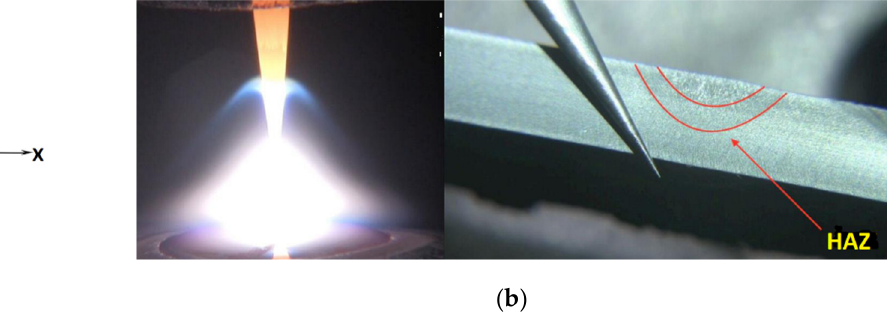
Figure 1. ( a ) Gaussian surface heat source model. ( b ) Tungsten arc profile and fusion zone and heat-affected zone (HAZ) widths.